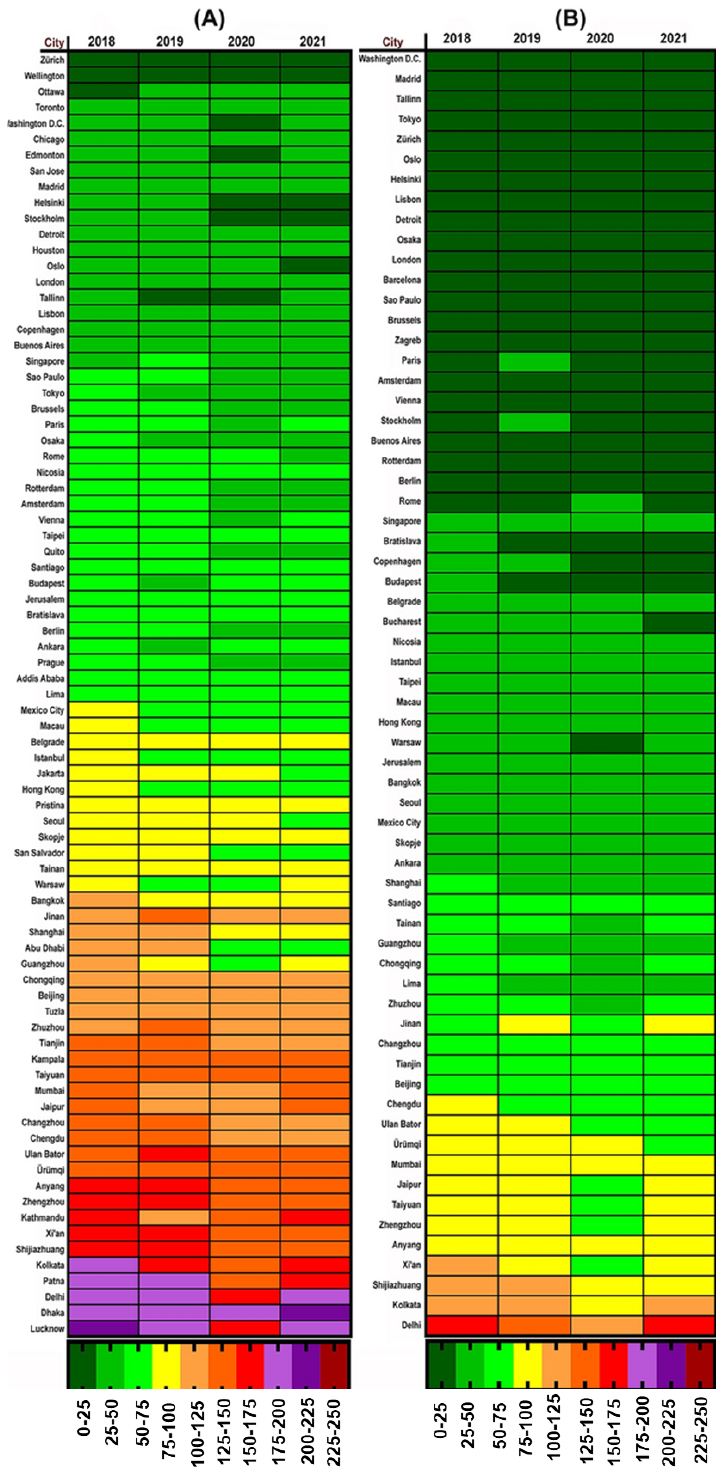
Figure 2. Heat map created with GraphPad Prism showing average medians of the four first months ’ Nature.